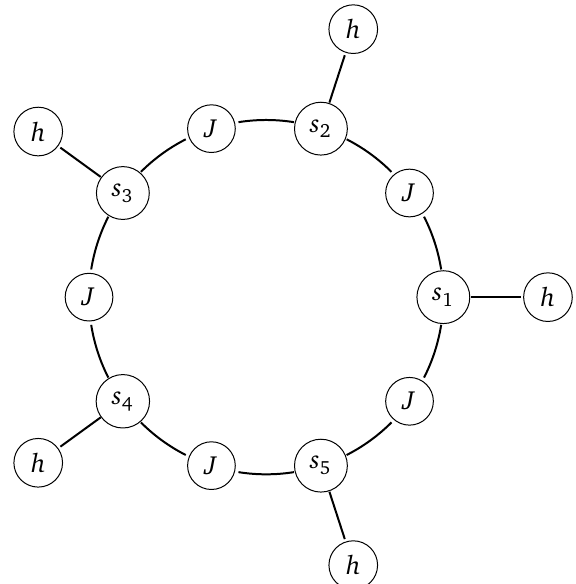
Figure 19: A tensor network representing the 1D Ising model is shown with periodic boundary conditions and N = 5 sites. The tensors labeled J encode the interactions, those labeled h encode the onsite term, and those labeled s delta tensors which enforce the condition that each interaction involving any given spin sees the same spin as each other such